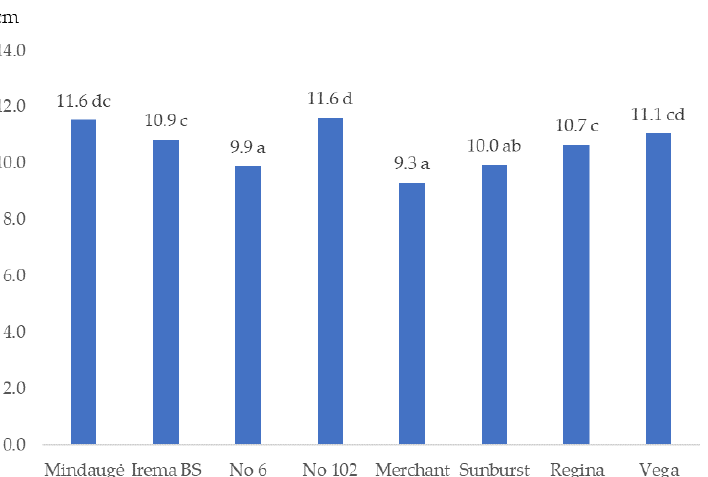
Figure 1. Sweet cherry tree trunk diameter in autumn 2021 in cm. Values marked with different letters are statistically different ( p ≤ 0.05).